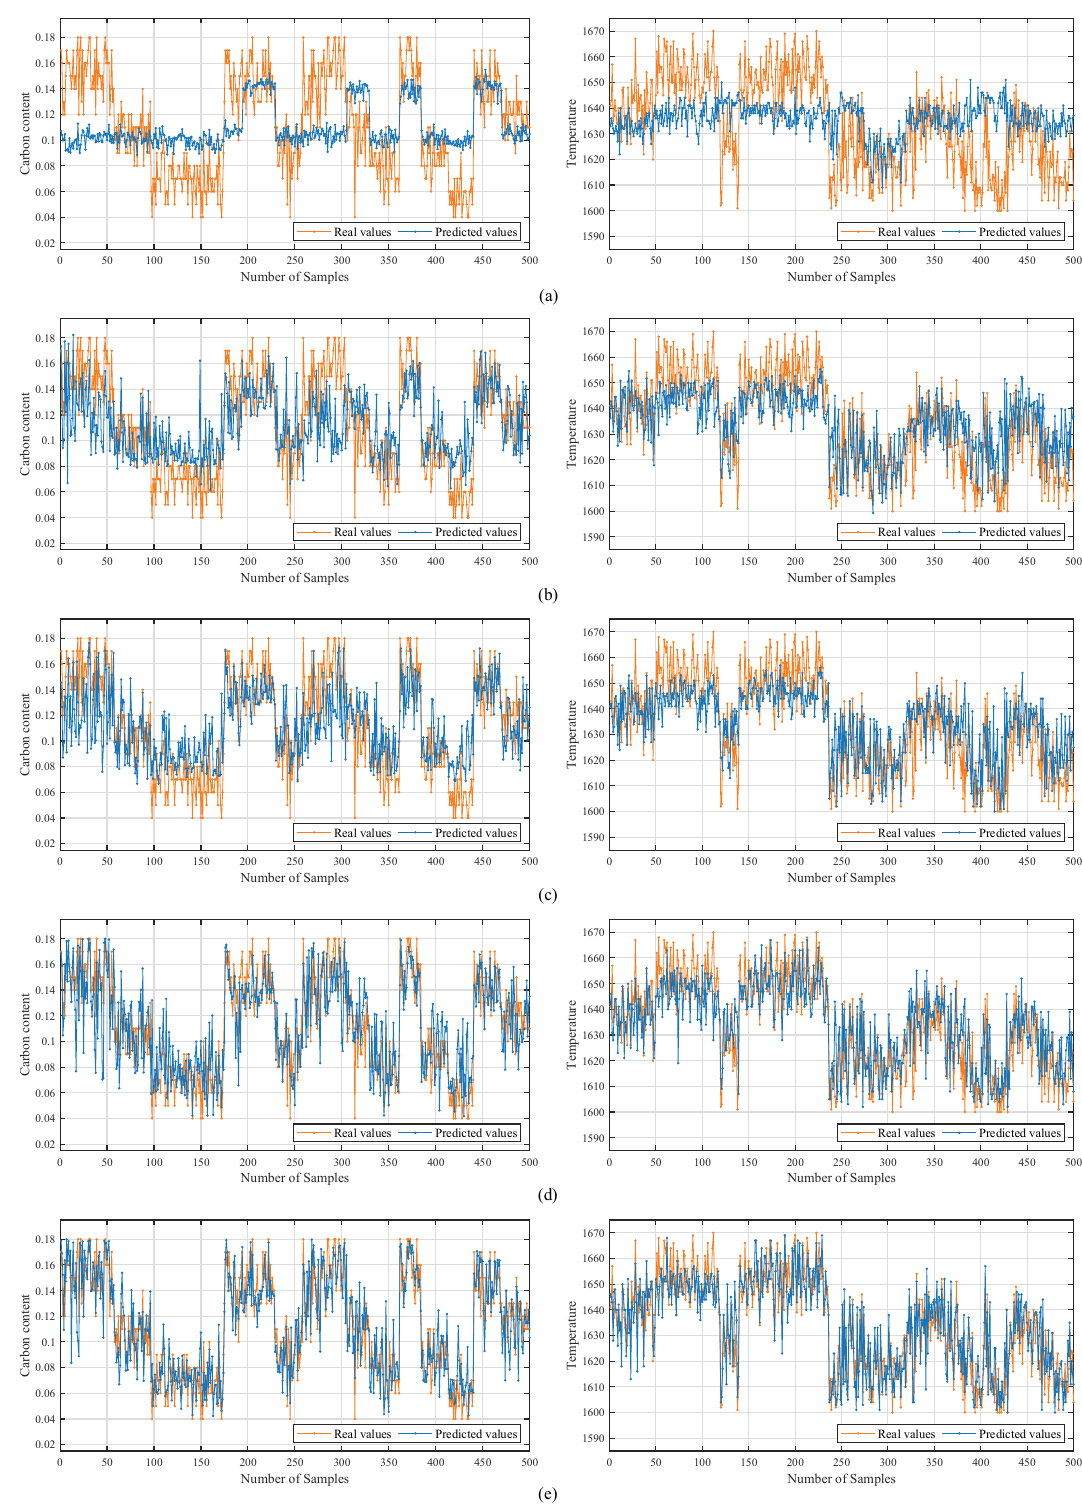
Figure 9: Detailed prediction results for carbon content ( left ) and temperature ( right ) test datasets: ( a ) PLS, ( b ) BPNN, ( c ) SAE, ( d ) vMF - SAE, ( e ) vMF - WSAE ( ED ) , and ( f ) vMF - WSAE ( WED )